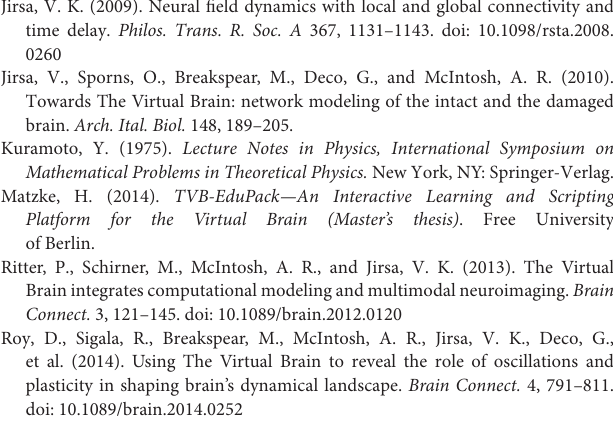
Supplementary Figure 1 | Description of TVB-EduPack menu: After a user finished all tasks of a section, the number should be zero. Here, the user opened the next section—it indicates four open tasks while one of them is already active. All elements are colored red/orange as indicator for the parameter-type related